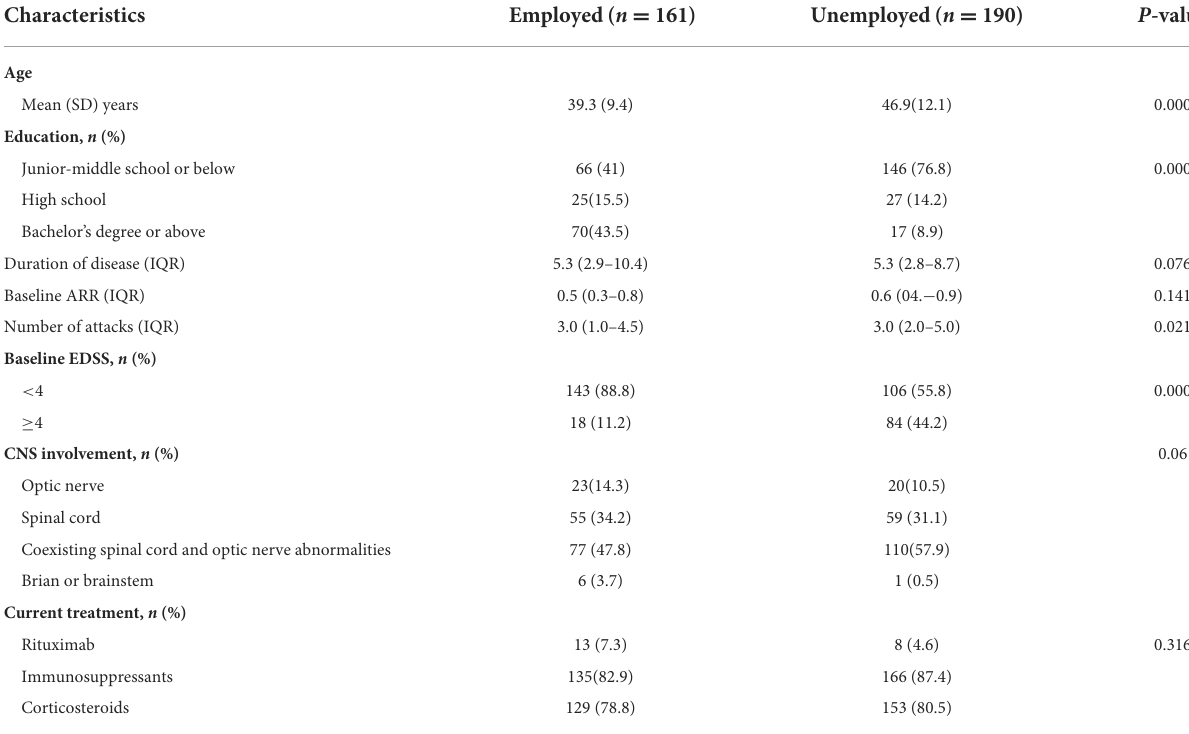
TABLE 1 Demographic and clinical data of employed and unemployed patients with female neuromyelitis optica spectrum disorder.